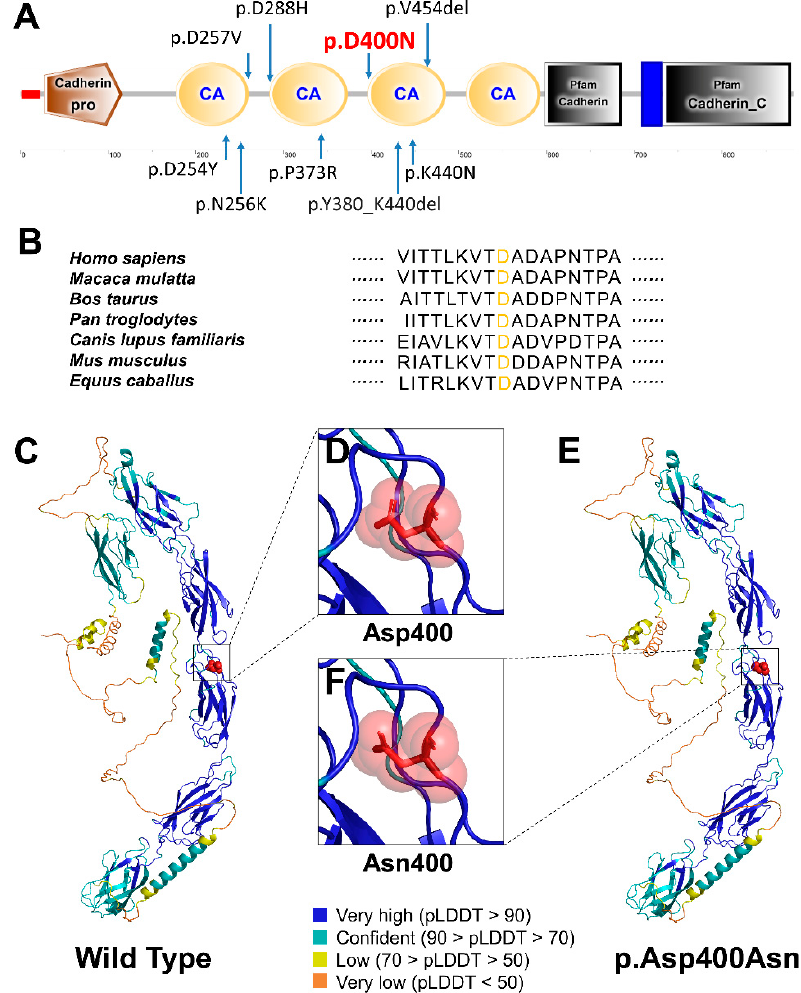
Figure 3. Location and conservation and conformational analyses of CDH1 variant p.Asp400Asn. ( A ) Schematic diagram of the wild-type human CDH1 (NP_004351.1) protein and the distribution of the novel CDH1 variant identified in this study and reported variants identified in patients with BCD syndrome. ( B ) Conservation analysis of the affected amino acids in CDH1 protein. ( C ) Tertiary structure of the wild-type CDH1 protein predicted by AlphaFold. ( E ) Tertiary structure of the p.Asp400Asn variant CDH1 protein. ( D , F ) Predicted conformational consequences of CDH1: p.Asp400Asn.